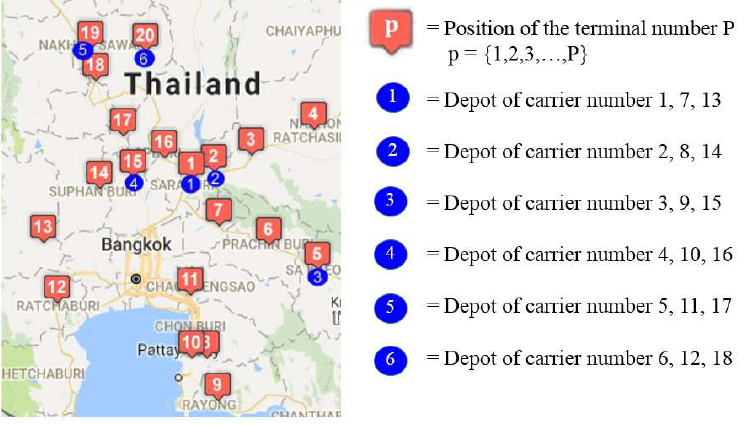
Fig. 5. Location of terminals (nodes) and depots of the